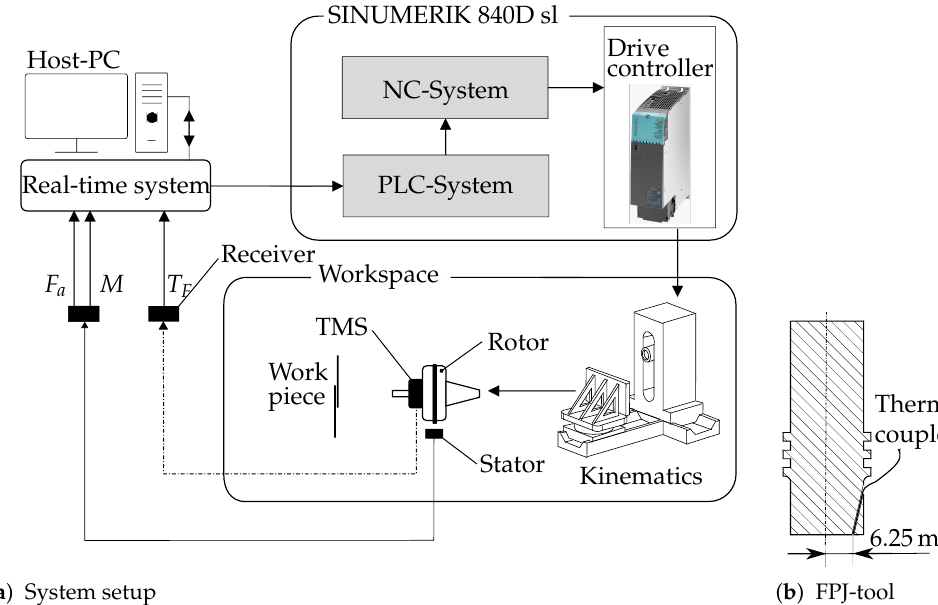
Figure 3. Illustration of the system setup for the implementation of the force and the temperature control ( a ), and a cross section of the used tool with inserted thermocouple at 6.25mm from the center ( b